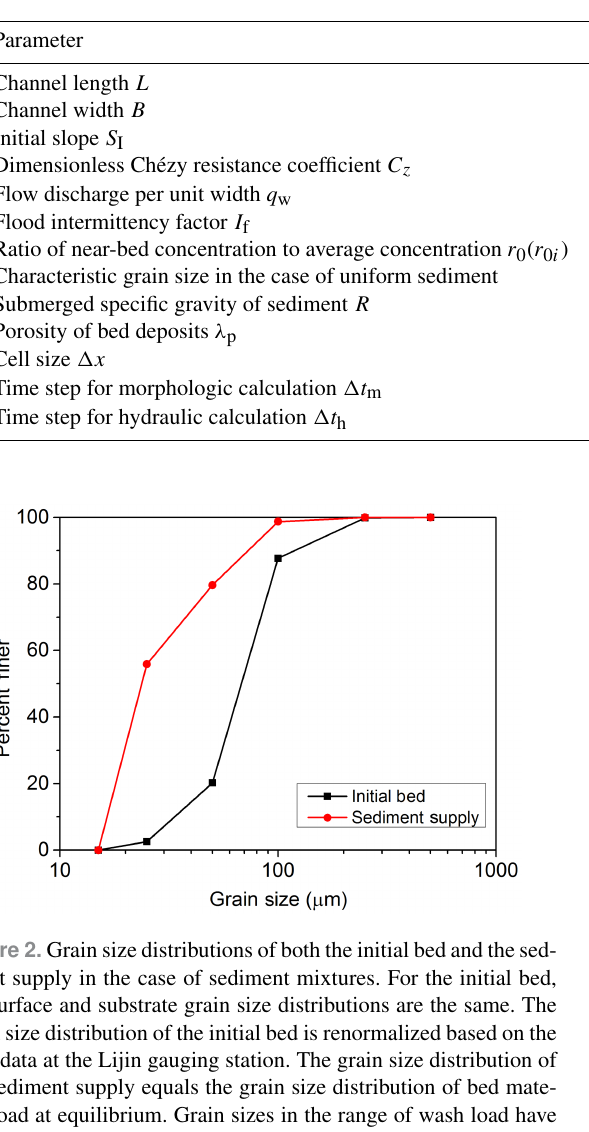
Table 1. Summary of computational conditions for numerical modeling of the LYR.